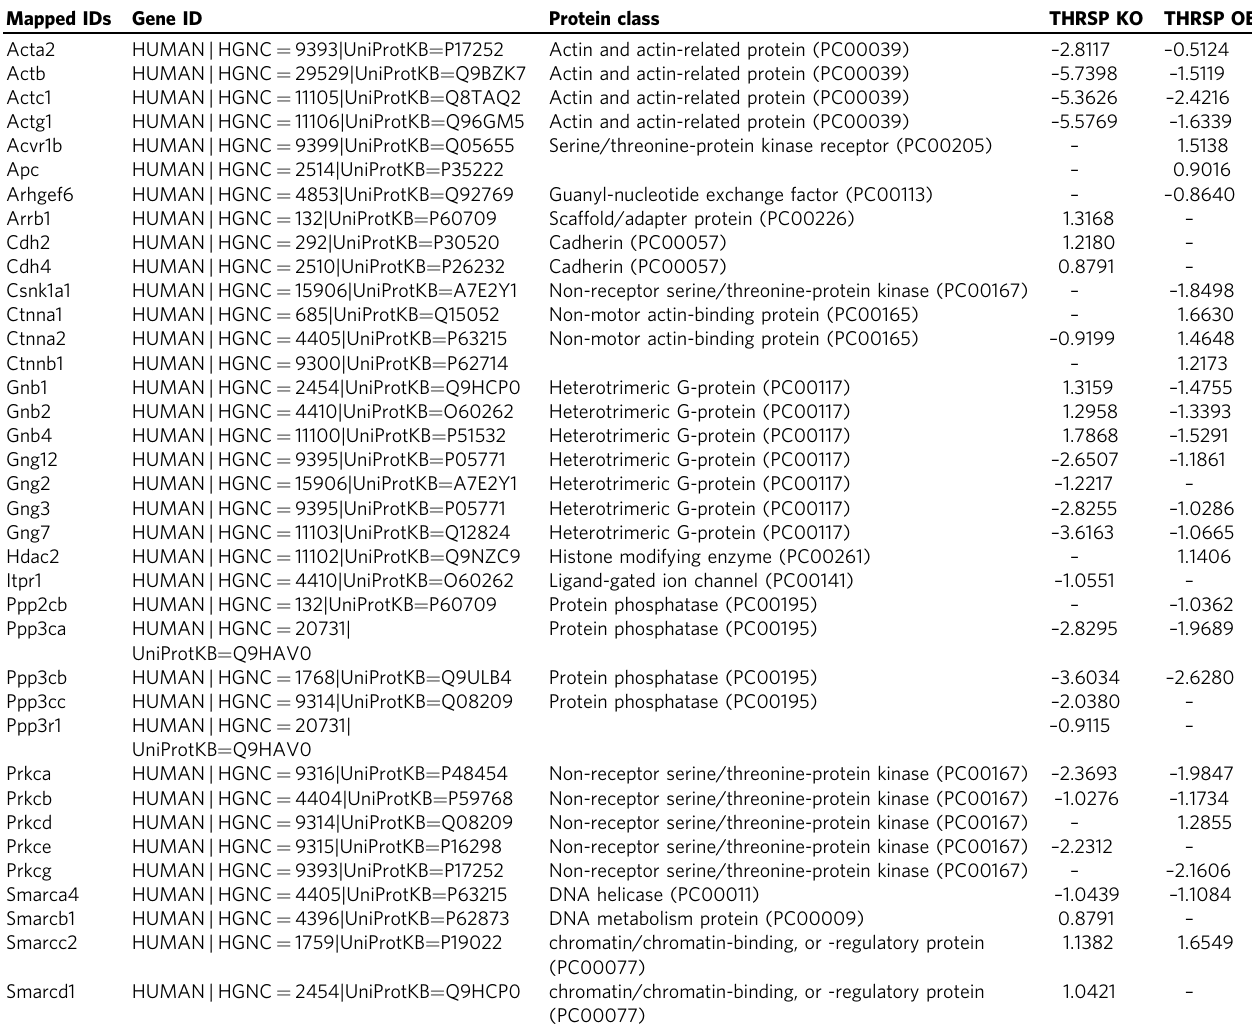
Table 3 Common upregulated and downregulated proteins in THRSP KO and OE mice involved in Wnt signaling. Mapped IDs Gene